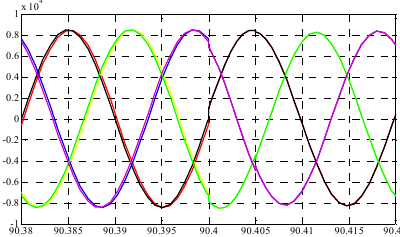
Figure 9. Comparison of three-phase voltage before and after grid connection.